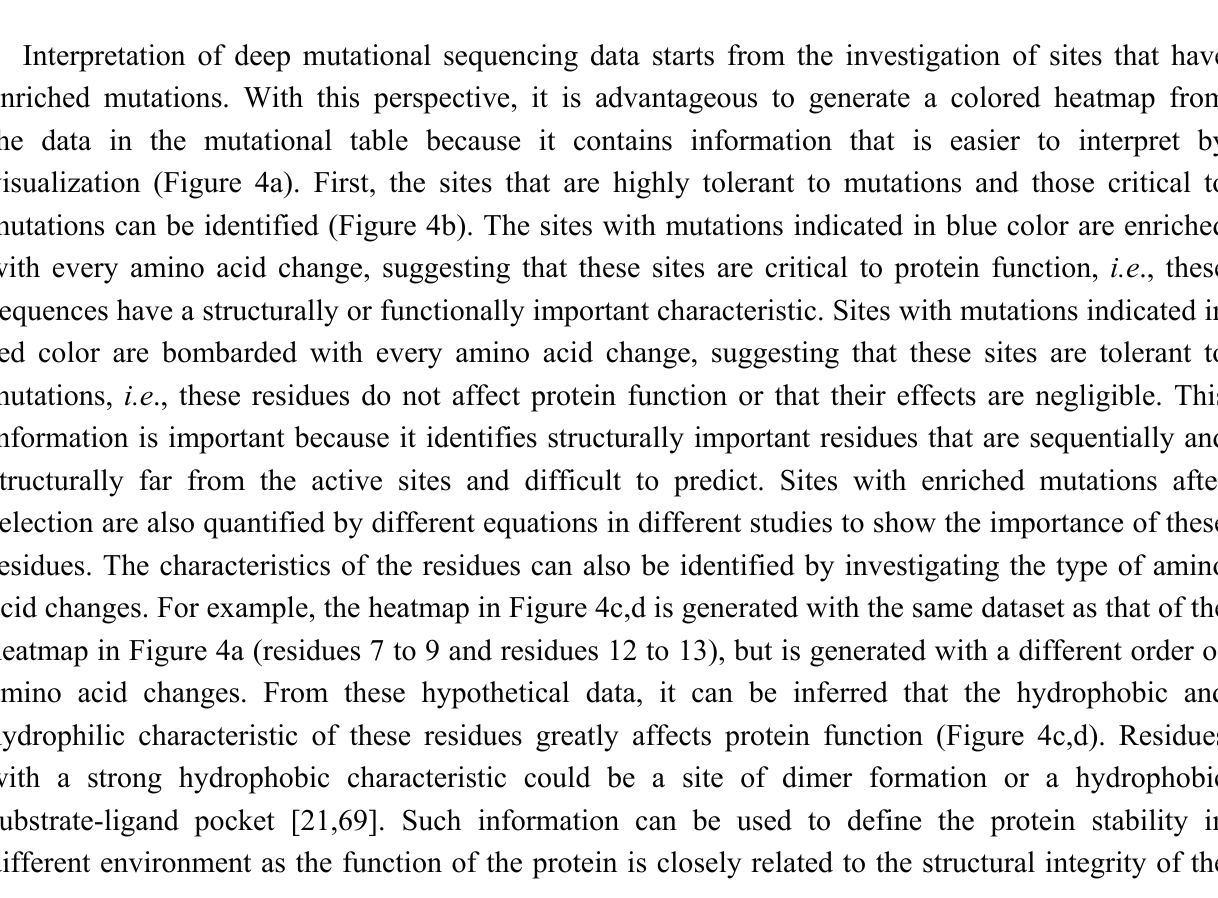
Figure 4. ( a ) A hypothetical mutational map generated to show mutation frequency at each position; Part of the mutational map showing ( b ) extremely tolerant and critical residues to mutations; ( c ) tolerant to hydrophobic mutations and ( d ) tolerant to hydrophilic mutations. The x-axis indicates the protein residues and the y-axis indicates the possible amino acids. The color key represents the mutation frequency at each amino acid. The white color indicates that no mutation was found. The blue color indicates mutation frequency of loss-of-function variants and red color indicates mutation frequency of function-retained variants. The stop codon is indicated by *